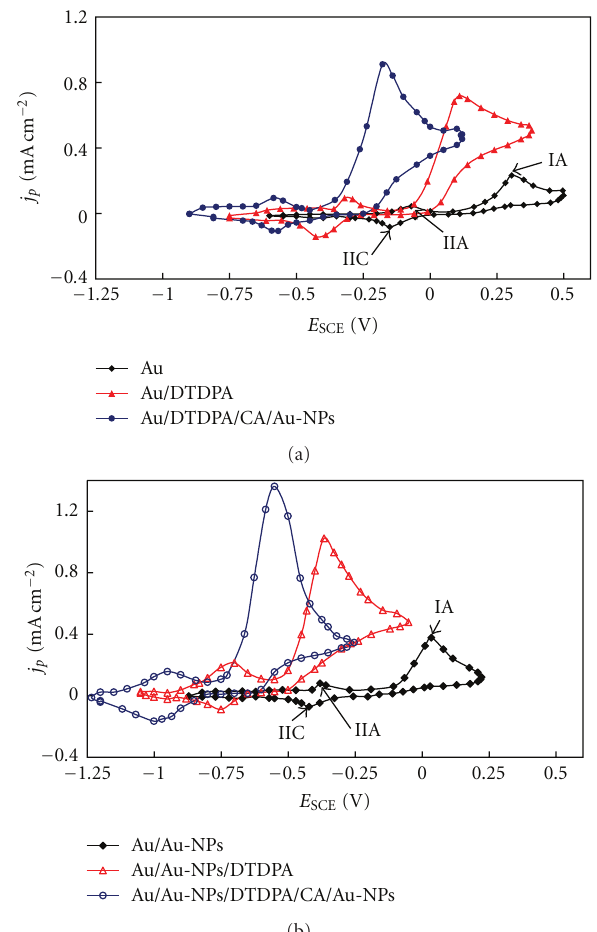
(b) Figure 4: Cyclic voltammograms of pure and modified gold electrodes at (a) 2D and (b) 3D template in 60mM phosphate bu ff er (pH = 7) with 500 µ M EP. v = 0 . 1Vs − 1